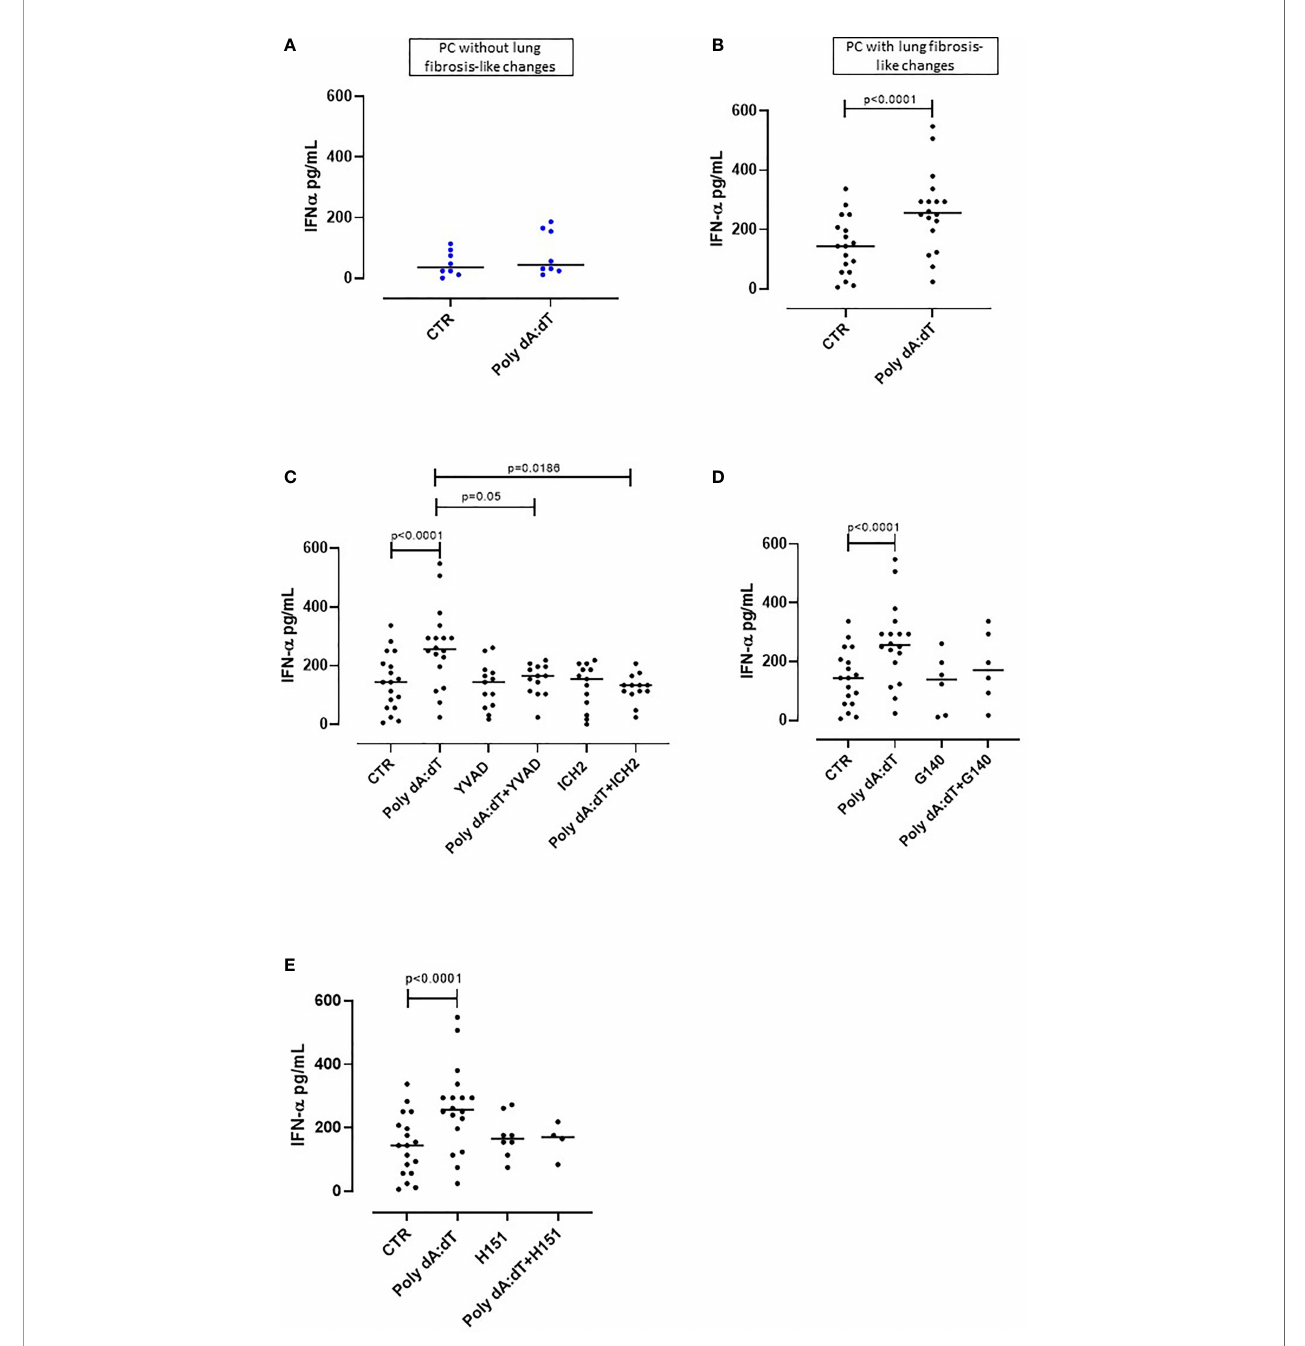
FIGURE 2 | AIM2 in fl ammasome activation induced IFN- a release from PBMCs obtained from Post-COVID-19 patients with fi brosis. PBMCs were stimulated with Poly dA:dT (1 m g/mL) for 5 hours. (A) PBMCs from Post-COVID-19 (PC) patients who did not develop lung fi brosis did not release IFN- a after AIM2 activation. (B) PBMCs from PC patients who developed lung fi brosis signi fi cantly released IFN- a after AIM2 activation. (C) Inhibition of caspase-1 and caspase-4 with Ac-YVAD- cmk (YVAD, 1 m g/mL) and ICH2 (ICH2, 6,4 m g/ml), respectively, did not reduce the release of IFN- a after Poly dA:dT stimulation. Inhibition of (D) cGAS with G140 (2 m g/ml) or (E) STING with H-151 (H151, 1 µg/mL), did not alter the release of IFN- a after Poly dA:dT stimulation. Data are reported as median and represented as scatter dot plots. Statistical analysis was performed using the Wilcoxon matched-pairs signed rank